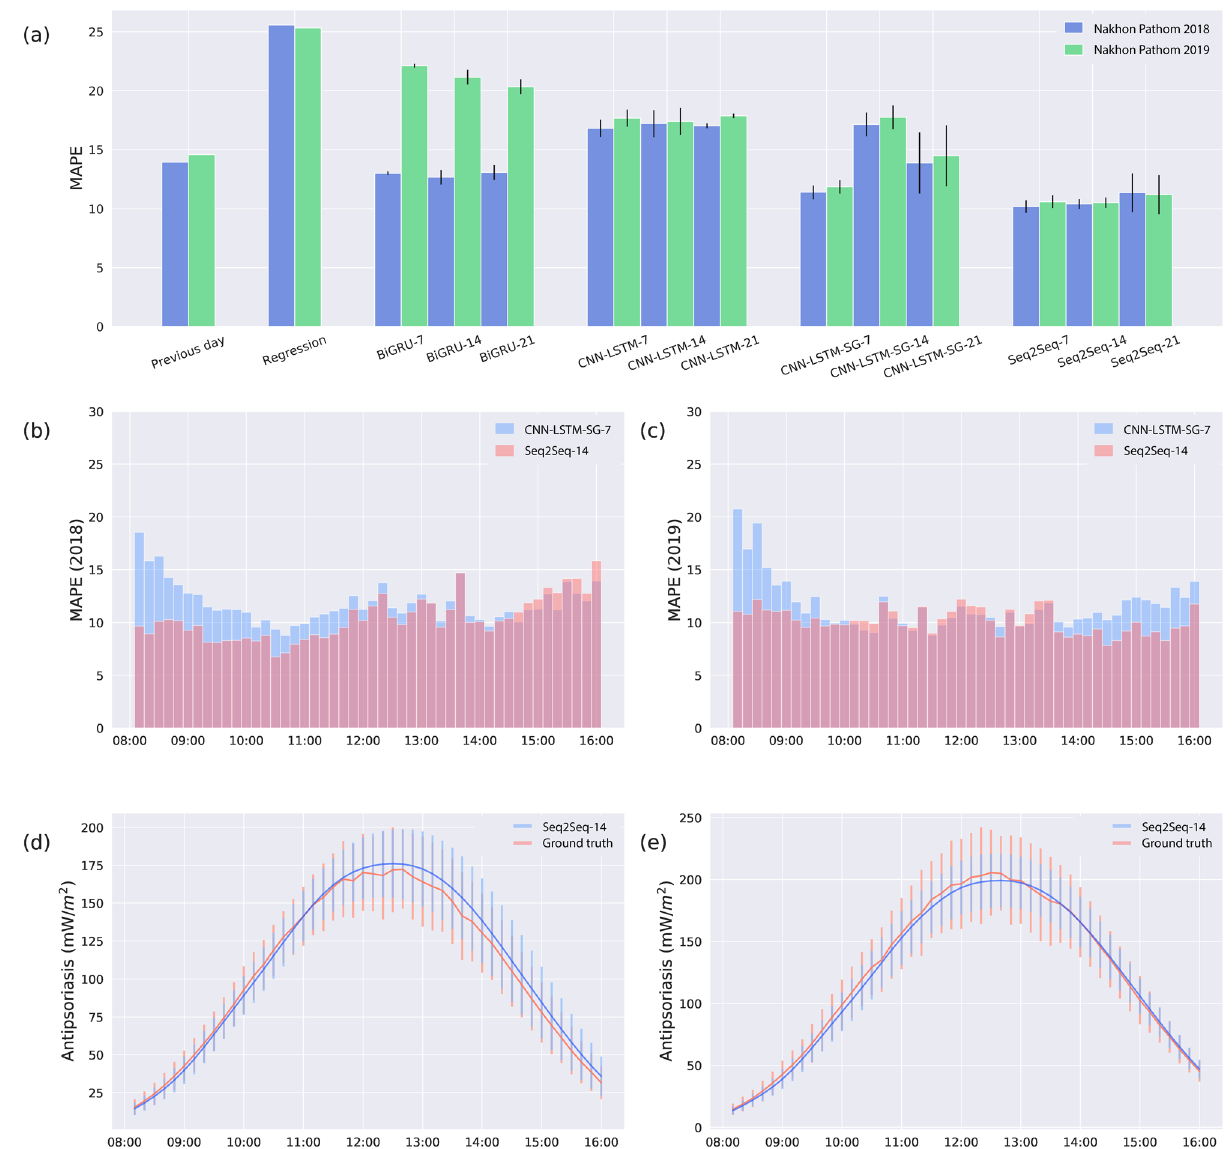
Figure 3. SurfUVNet accurately forecast antipsoriatic irradiance throughout the day. Results on Nakhon Pathom dataset were shown. ( a ) Comparison of the mean absolute percentage errors (MAPE) for the next-day antipsoriatic irradiance forecast between SurfUVNet (Seq2Seq-14) and four benchmark models (see “Methods” section). Previous day model simply predicts next-day’s UV radiation to be the same as today’s. Regression model refers to the regression model based on Earth–Sun distance and total ozone column currently in used by the Thai Meteorological Department 22 . BiGRU is an artificial neural network architecture that is often utilized for time series forecasting. CNN-LSTM, and CNN-LSTM-SG are artificial neural network models that were recently applied to UV forecasting in the energy domain 27 . The tags − 7, − 14, and − 21 designate the length of UV data, in days prior to the forecast date, that were input into each model. ( b ) Distribution of MAPE for the validation set (UV data from 2018) throughout the times of the day. Results for the best performing models, namely CNN-LSTM-SG-7 and SurfUVNet (Seq2Seq-14), are shown. ( c ) A similar plot showing distribution of MAPE for the test set (UV data from 2019). ( d ) Comparison of ground truth UV data and forecasts made by SurfUVNet for the validation set (UV data from 2018). Error bars indicate one-standard deviation ranges. ( e ) A similar plot for the test set (UV data from